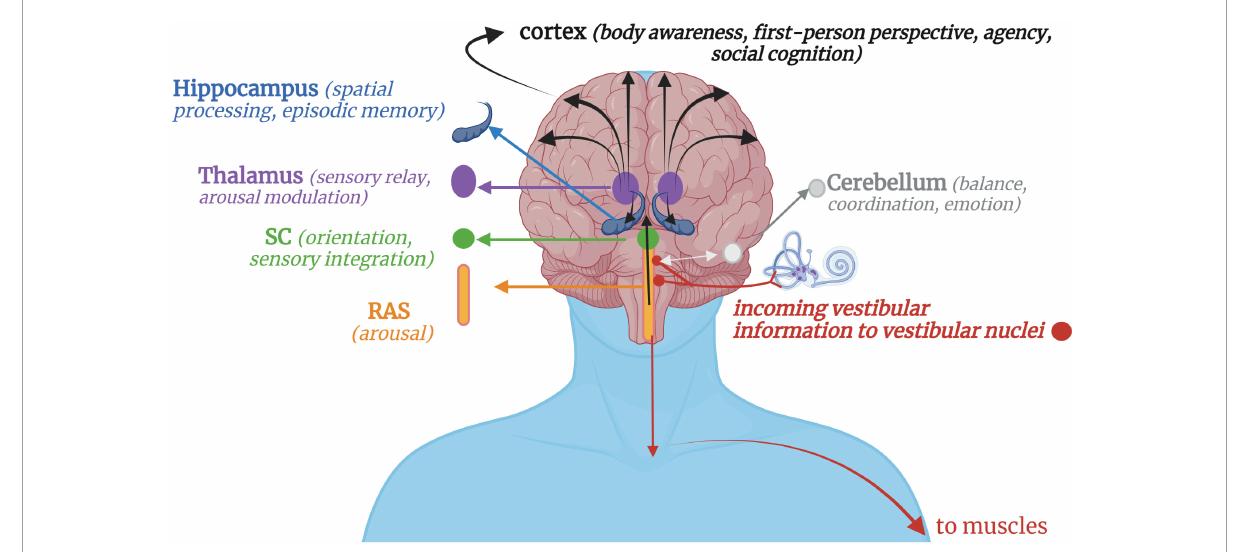
FIGURE1 A simplified schematic of vestibular projections throughout the nervous system. Afferent input from gravitational forces arrives at the vestibular nuclei, which integrate with somatosensory input via the cerebellum, reticular formation, and spinal afferent tracts. Downward vestibular efferent projections send signals for muscular extension and postural control. Reciprocal connections with the cerebellum, mainly its flocculonodular lobe, allow for feedback-feedforward mechanisms of motor coordination and fluency, with the cerebellum projecting information back to the vestibular nuclei or directly up to the cortex. Ascending vestibular projections integrate with the RAS and SC for arousal modulation and orienting responses before continuing on to higher cortical structures via the thalamus. Vestibular projections to the cortex then contribute to higher-order cognitive processes such as a sense of agency, first-person perspective, social cognition, and bodily self-consciousness. RAS, Reticular activating system; SC, Superior